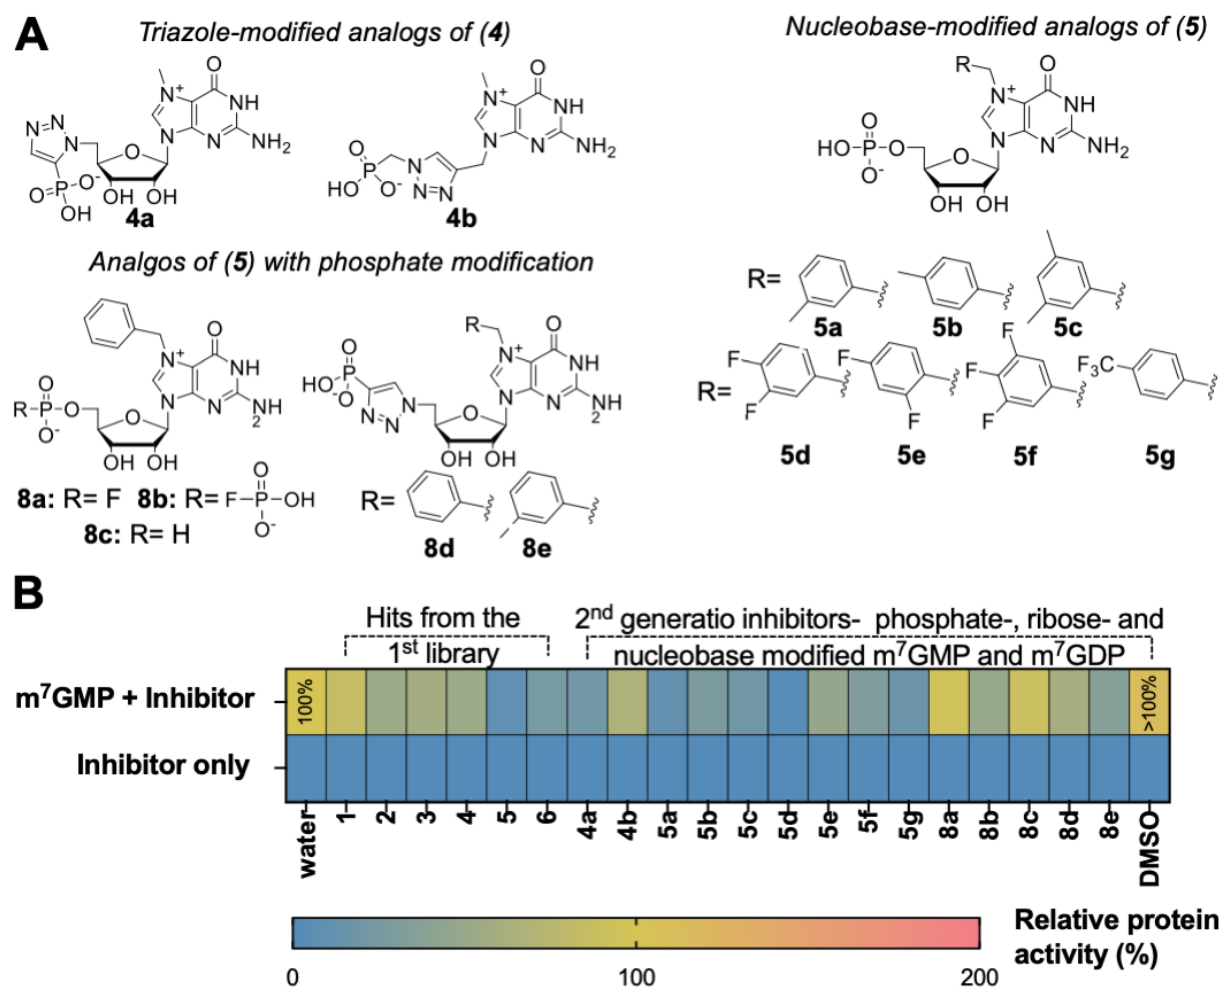
Figure 4. Evaluation of the second ‐ generation inhibitors. ( A ) Structures of the potential second ‐ generation inhibitors of cN ‐ IIIB enzyme. ( B ) Inhibitory potency and hydrolysis of 14 compounds of the second library, which includes 6 leading compounds from the first library. Inhibitory potency was introduced as the % of m 7 GMP—substrate dephosphorylation by cN ‐ IIIB enzyme in the presence of inhibitor. Depending on the solubility of compounds, their stock solution was dissolved in water or DMSO, and the graph presents the control reaction for both solvents. The data represent mean values ± SD from triplicate.